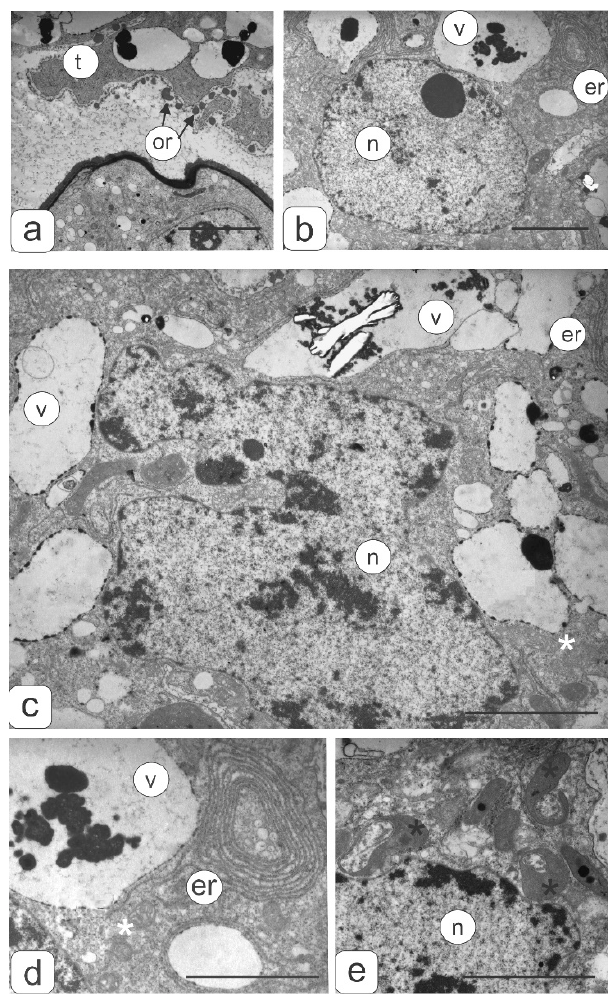
Figure 7. Tapetal cell ultrastructure of transgenic tomato plants (2 disturbances types) with violations of flower morphology. ( a ) Fragment from contact zone of tapetal cell and microspore. Orbicules are visible on the tapetum surface. ( b ) Fragment of tapetal cell. ( c ) Polyploid nucleus of tapetal cell. Tapetal cell fragments with ER ( d ) and plastids ( e ). Symbols: er—endoplasmic reticulum; v—vacuole; n—nucleus; or—orbicules; black asterisks—plastids, white asterisks—mitochondria. Bar—2 μ m.